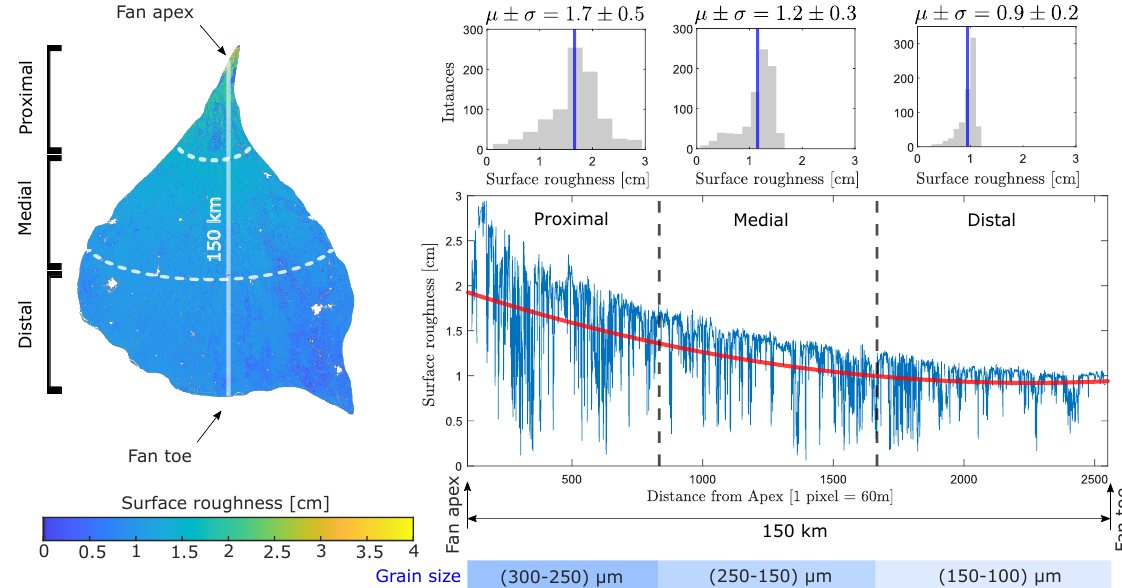
Figure 12. Surface roughness variation from the proximal to distal part of the Kosi fan. The graph in the bottom right illustrates the surface roughness against the distance from fan apex to the toe. Histograms show the corresponding distribution of surface roughness in the proximal, middle and distal parts of the Kosi